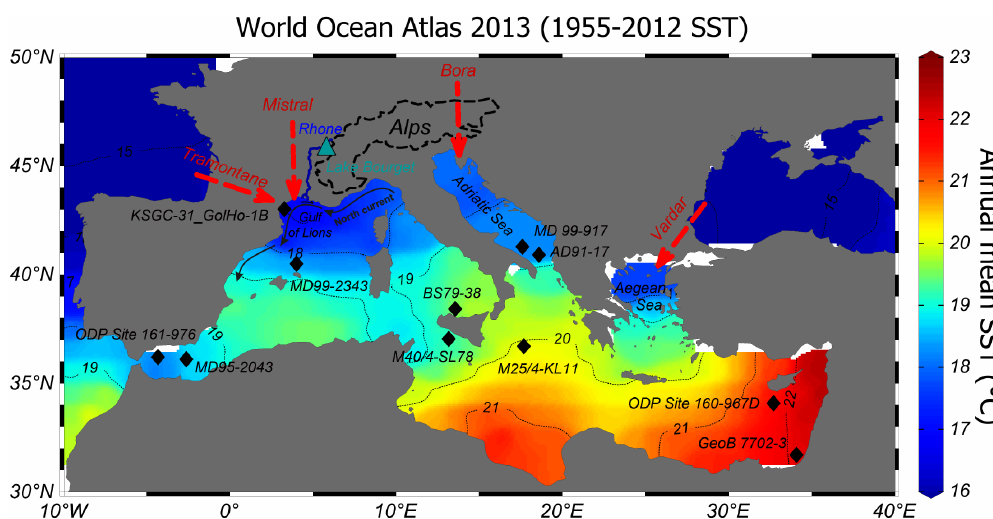
Figure 1. Map of the Mediterranean annual mean SSTs ( ◦ C; 1955 and 2012) from Word Ocean Atlas 2013 (http://odv.awi.de/de/data/ocean/ world_ocean_atlas_2013/) plotted using Ocean Data View (Brown, 1998). The location of the KSGC-31_GolHo-1B core and other sites discussed in the text are also reported (from West to East): ODP Site 161–976, Alboran Sea (Martrat et al., 2014); MD95-2043, Alboran Sea (Cacho et al., 2001); MD 99-2343, Balearic basin (Frigola et al., 2007); M40/4-SL78, Ionian Sea (Emeis et al., 2003); BS79-38, Southern Tyrrhenian Sea (Cacho et al., 2001); MD90-917, Southern Adriatic Sea (Essallami et al., 2007); M25/4-KL11, the Ionian Sea (Emeis et al., 2003); AD91-17, Southern Adriatic Sea (Giunta et al., 2001); ODP Site 160-967D, Levantine basin (Emeis et al., 2000); GeoB 7702-3, Levantine basin (Castañeda et al., 2010). The location of Lake Bourget in France (LDB01-1 and LDB04-1 cores) is also shown (Arnaud et al., 2012). The main winds blowing in the Mediterranean Sea are shown by red